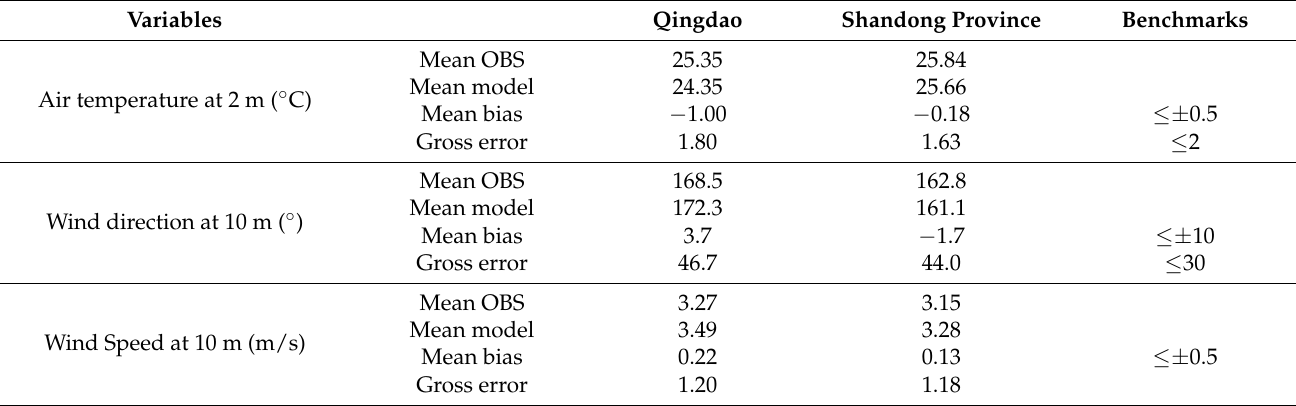
Figure 4. Composite geopotential heights (blue contour, units: m) at 500 hPa and observed MDA8 ozone anomalies (units: ppb) compared to the summer mean of 2014–2019 for high-ozone events in Qingdao during summer 2014–2019. Table 3. Evaluation of WRF simulation. OBS represents data from observations. Model represents results from controlled experiments in the WRF-CMAQ